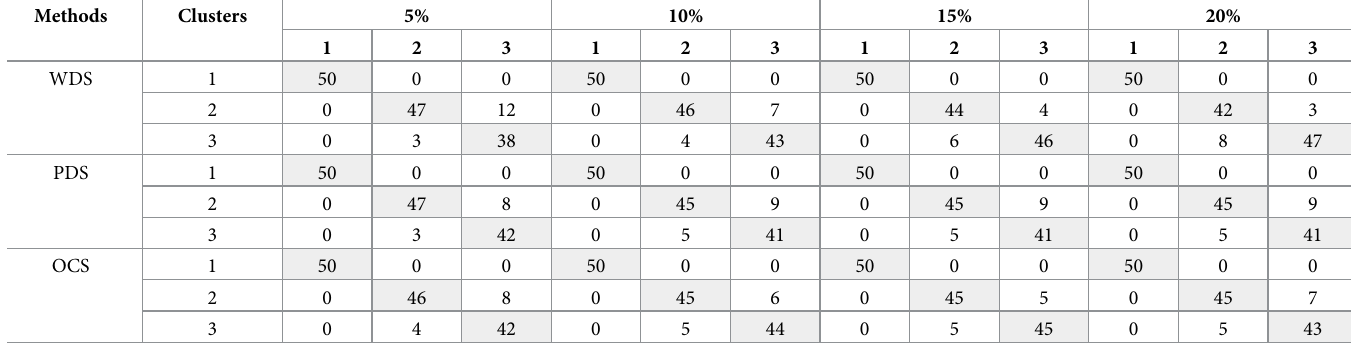
Table 2. Confusion matrices obtained by the VKFCM-K-LP algorithm with the WDS, EDP and OCS strategies using 5%, 10%, 15% and 20% of missing values. Methods Clusters